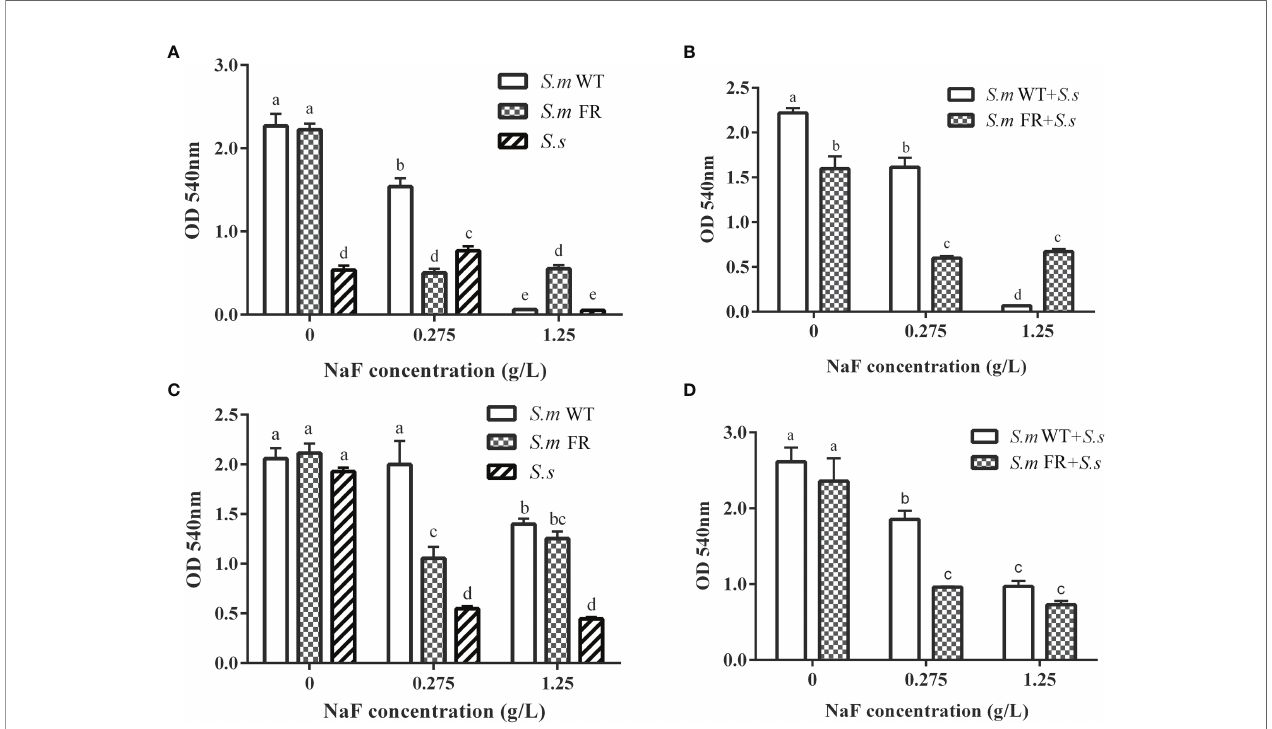
FIGURE 4 | Metabolic activity measured using MTT assay. (A) Single-species bio fi lm formation. (B) Dual-species bio fi lm formation. (C) Pre-formed single-species bio fi lms. (D) Pre-formed dual-species bio fi lms. The same letters indicate no statistical difference, and different letters indicate a signi fi cant difference between groups ( P <